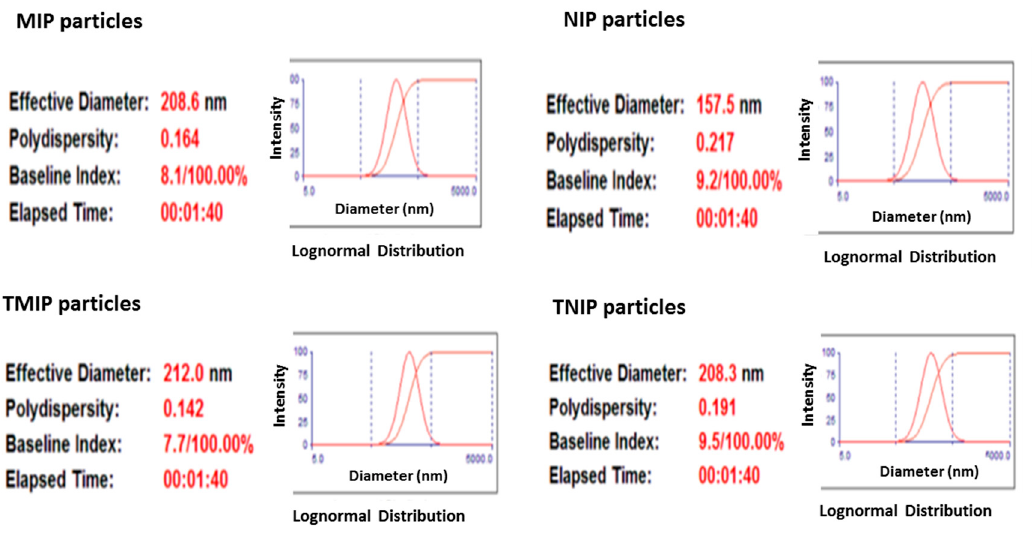
Figure 6. Dynamic light scattering analysis of MIP, NIP, TMIP and TNIP particles.